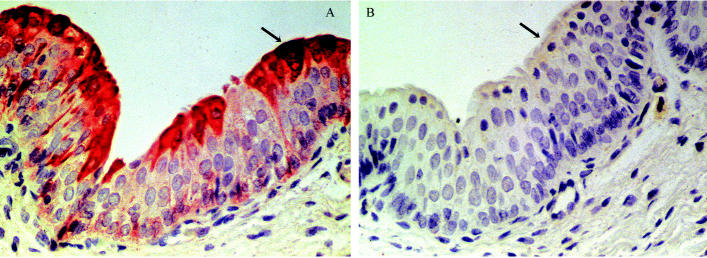
CYP1A1 expression in transitional epithelium from the bladder of Arctic beluga whale. CYP1A1 is labeled pink to dark red; arrows indicate cells with labeling and the identical cell type without labeling. (A) CYP1A1 expression in the transitional epithelium of bladder; labeling is most intense in the umbrella cells. (B) Serial section from beluga shown in (A) labeled using the nonspecific antibody UPC-10. Magnification, 400×.